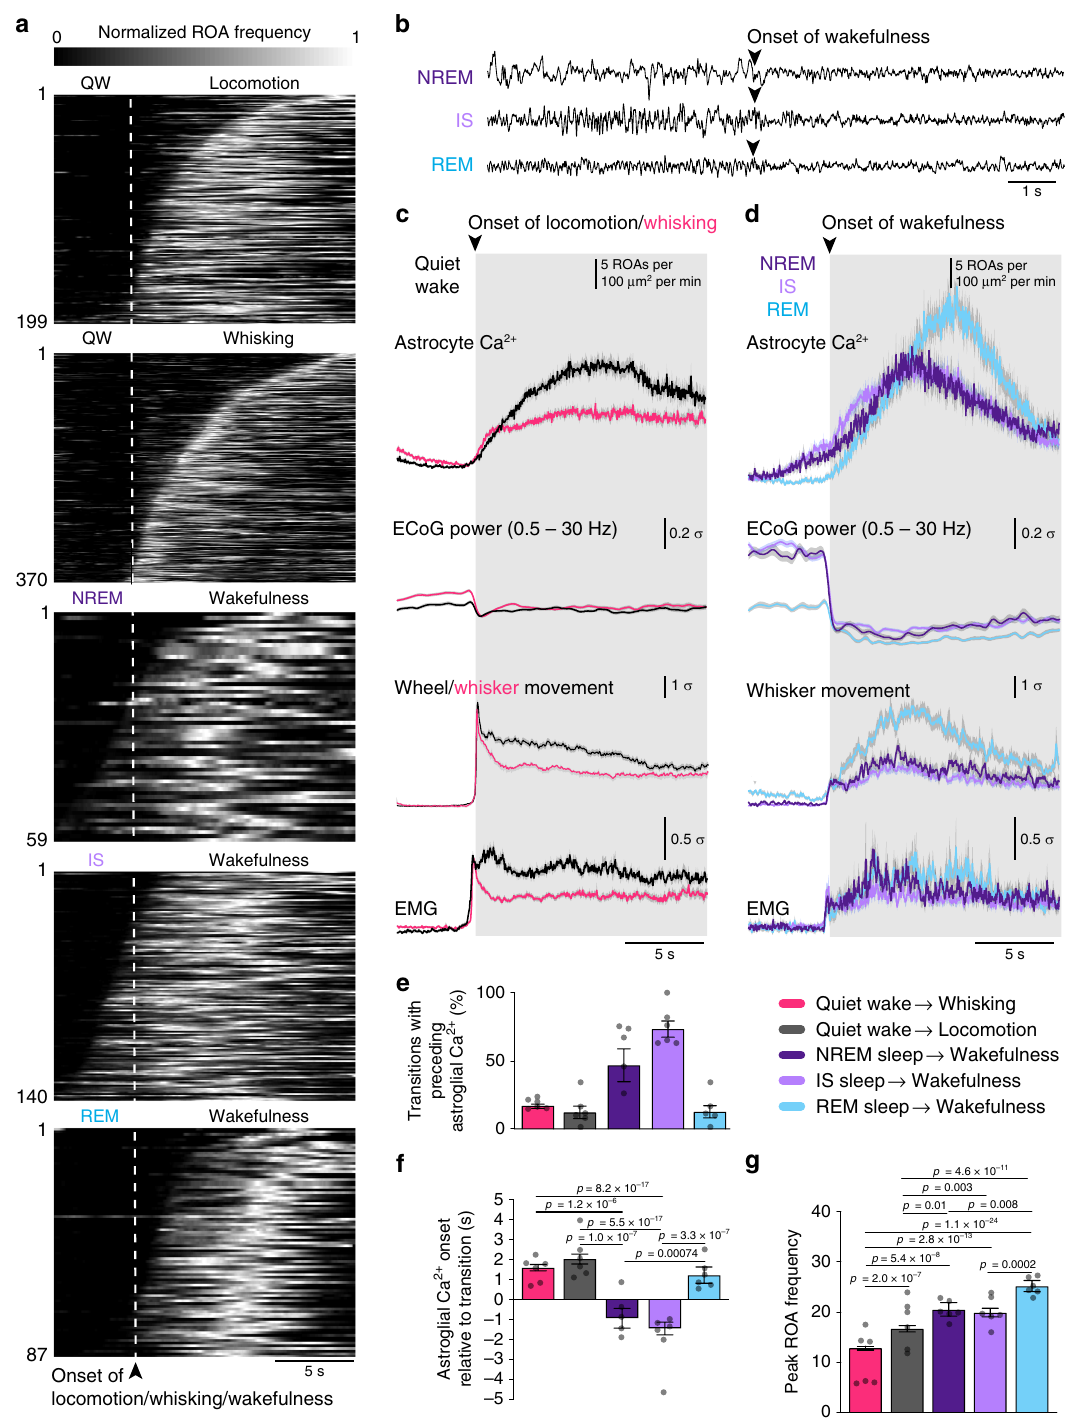
Fig. 5 Astrocytic Ca 2 + signals increase prominently upon awakening. a Temporal raster plots of normalized ROA frequency during the transitions (top to bottom): quiet wakefulness to locomotion ( n = 199 transitions); quiet wakefulness to whisking ( n = 370 transitions); NREM sleep to wakefulness ( n = 59 transitions); IS sleep to wakefulness ( n = 140 transitions); REM sleep to wakefulness ( n = 87 transitions). b Examples of transitions from NREM, IS, and REM sleep to wakefulness in the ECoG traces. c Mean time-course of (top to bottom) astrocytic Ca 2 + signals and z -scores of ECoG power, wheel or whisker motion and EMG activation during transitions from quiet wakefulness to locomotion or whisking. Data represented as mean ± SEM, n = 6 mice. d Same as c but for transitions from NREM, IS, or REM sleep to wakefulness. e Percentage of transitions with preceding astrocytic Ca 2 + signals. Data represented as mean ± SEM, n = 6 mice, number of samples for each transition described in a . f Astrocytic Ca 2 + signal onset relative to state transition. Data represented as estimates ± SE and p -values (two-sided test, no adjustment for multiple comparisons) derived from a linear regression model, n = 6 mice, number of samples for each transition described in a . g Peak frequency of ROAs during state transitions. Data represented as estimates± SE and p - values (two-sided test, no adjustment for multiple comparisons) derived from linear regression models, n = 6 mice, number of samples for each transition described in a . For details on statistical analyses, see “ Methods ” . See also Supplementary Figs. 12 and